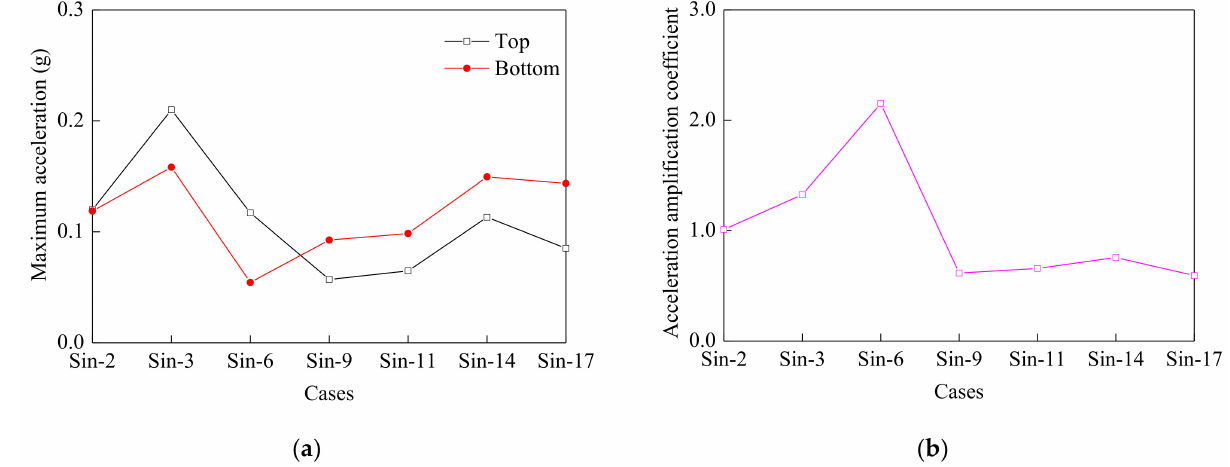
Figure 24. Maximum acceleration response at the top and bottom of the tunnel. ( a ) Maximum. ( b ) Amplification coefficient.